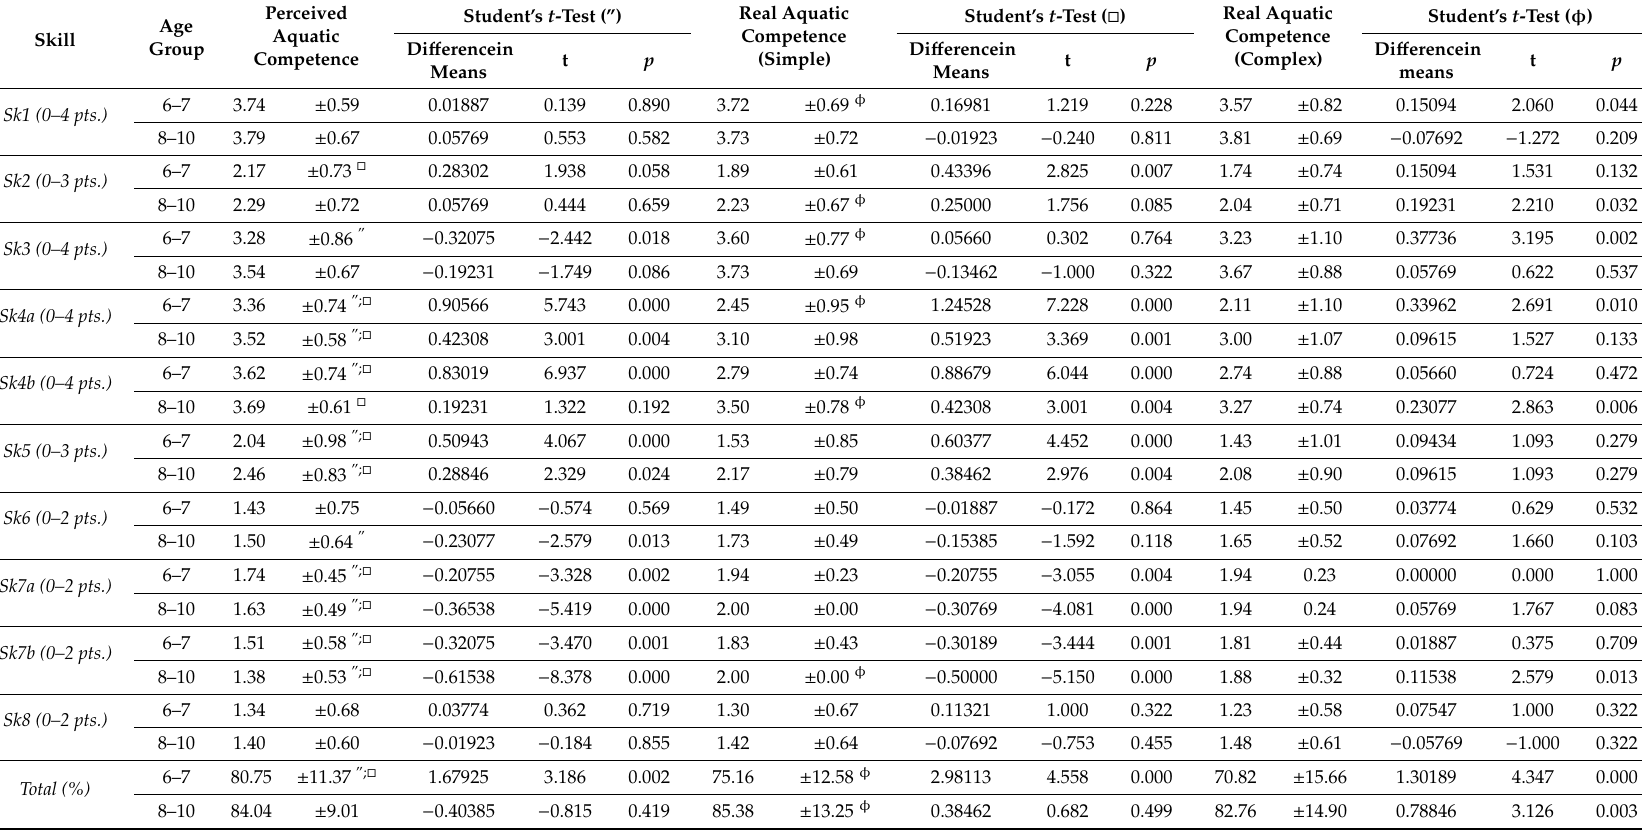
Table 2. Perceived and real aquatic competence (mean ± SD) for all the skills tested in both